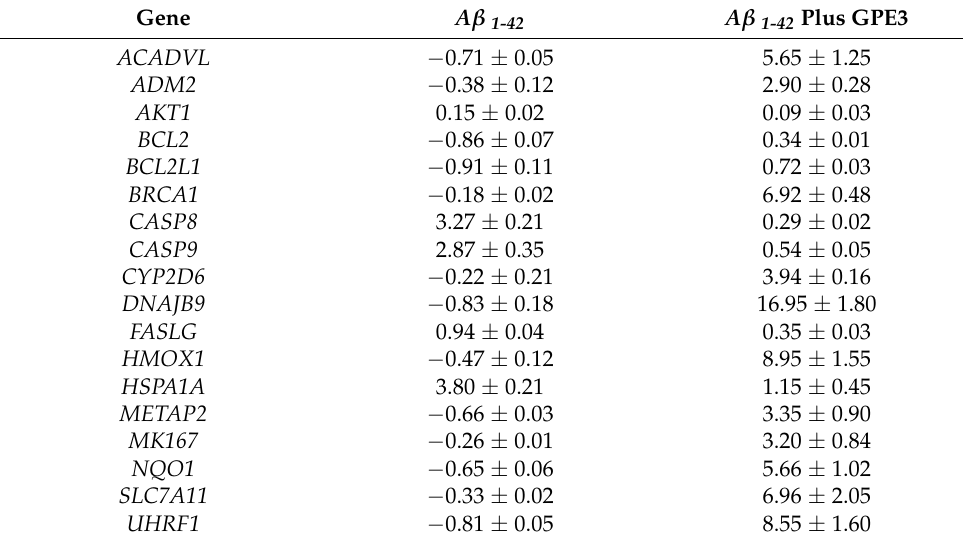
Table 5. The gene expression alterations (as fold